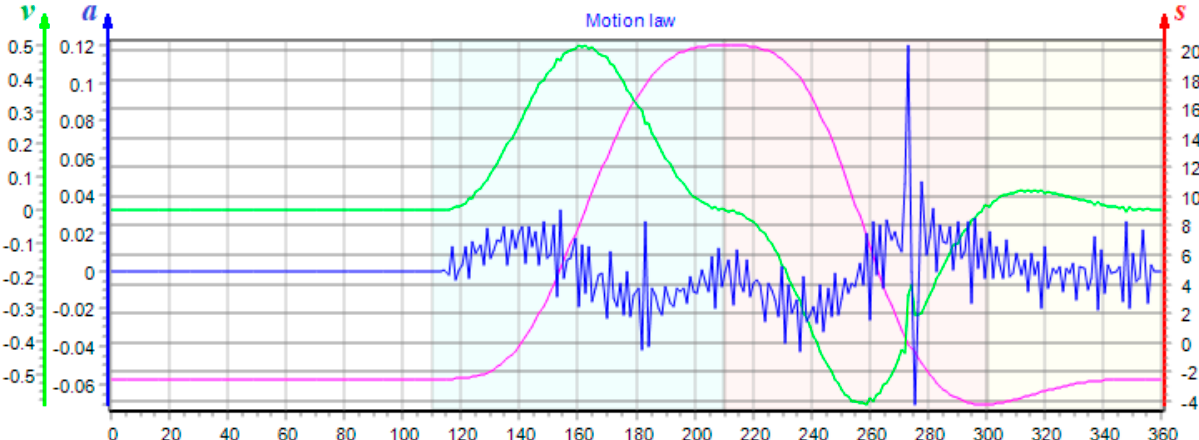
Figure 4. Acquired motion low of the follower movement of a damaged rocker arm (blue: acceleration; green: velocity; red: displacement). The law of motion is defined as a function of the rotation angle of the cam, and the displacement referring to the red vertical axis is a rotation of the follower in degrees.